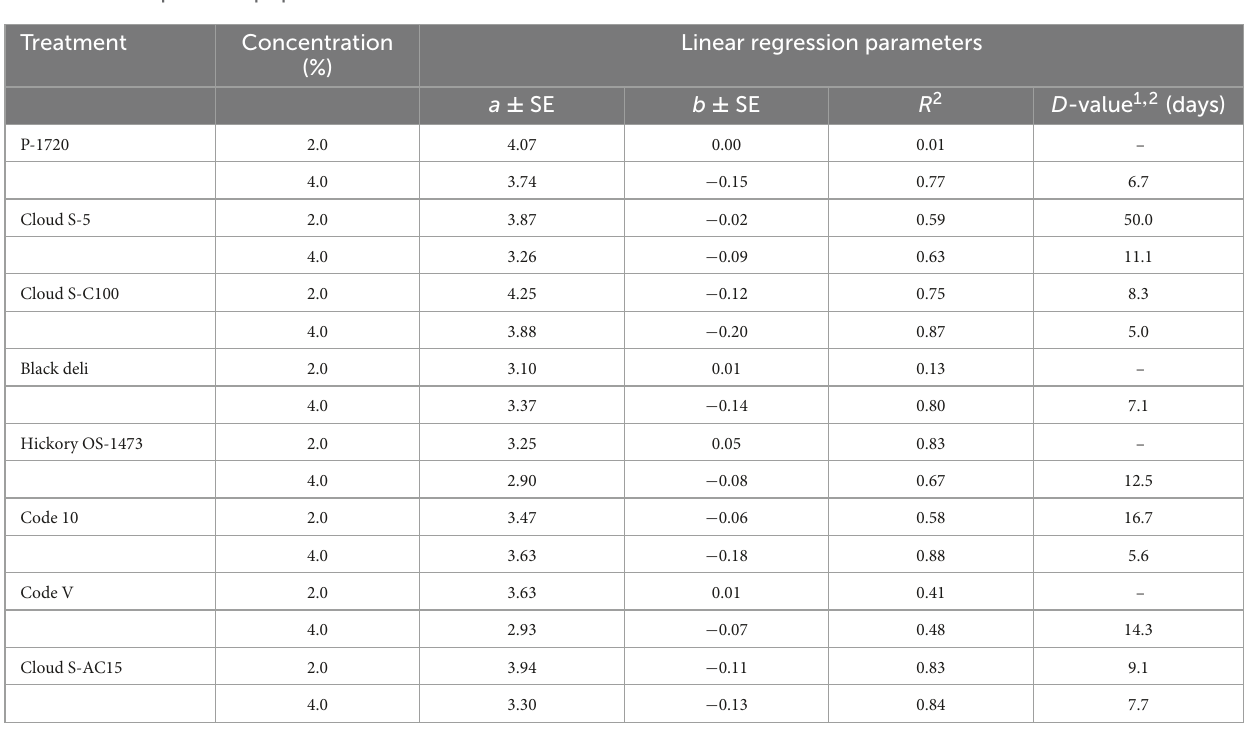
TABLE 7 Linear regression (linear model y = a + bx ) parameters of logarithmic reduction of Aspergillus flavus counts in semi-moist pet food treatments with inclusion of liquid smoke preparations at 2 and 4% concentrations.